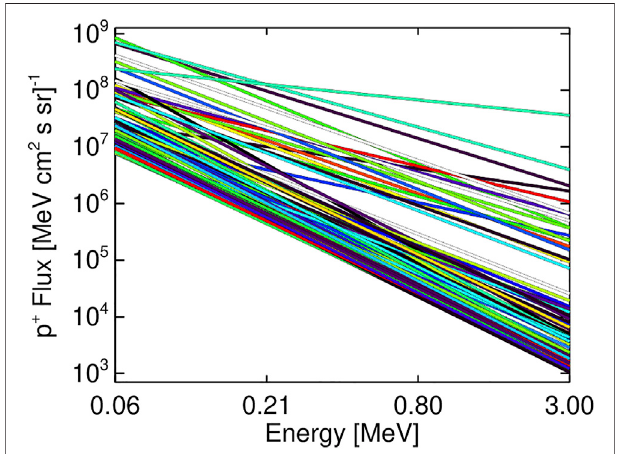
FIGURE 7 | The event input spectra for the DSA model, derived from 1 au quiet-time suprathermal observations.